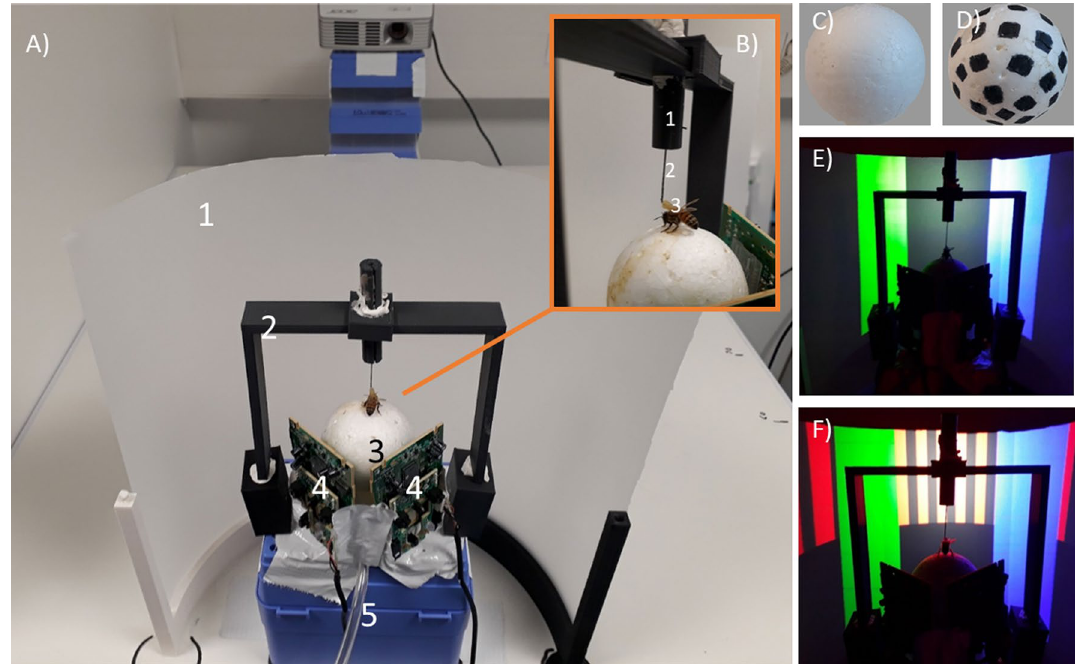
Figure 1. Experimental setup for 3D virtual-reality (VR) studies in honey bees. ( A ) Global view of the VR system. 1: Semicircular projection screen made of tracing paper. 2: Holding frame to place the tethered bee on the treadmill. 3: The treadmill was a Styrofoam ball positioned within a cylindrical support (not visible) and floating on an air cushion. 4: Infrared mouse optic sensors allowing to record the displacement of the ball and to reconstruct the bee’s trajectory. 5: Air arrival. ( B ) The tethering system. 1: Plastic cylinder held by the holding frame; the cylinder contained a glass cannula into which a steel needle was inserted. 2: The needle was attached to the thorax of the bee. 3: Its curved end was fixed to the thorax by means of melted bee wax. ( C , D ) Two types of Styrofoam balls used for assessing the importance of the ventral optic flow. ( C ) No ventral optic flow provided. ( D ) Ventral optic flow provided. ( E ) Color discrimination learning in the VR setup. The bee had to learn to discriminate a rewarded from a non-rewarded color cuboid. Cuboids were green and blue. In this case color training and testing was set in the ‘ Transparent Condition ’, i.e. no background was provided and the VR display contained only the two colored cuboids on an empty dark background. ( F ) Same as in ( E ) but in this case, the vertical background of the VR arena was covered by a vertical grating made of black and reddish bars. Depending on its movements, the background gave origin to three different conditions : the ‘ Vertical Grating— Optic Flow Condition ’, in which the grating was set in closed loop conditions with respect to the bee movements; the ‘ Vertical Grating—No Optic Flow Condition ’, in which the grating was moved in synchrony with the bee’s gaze so that no motion cues could be derived from the background; and the ‘ Rotating Vertical Grating Condition ’, in which the grating was displaced in the anti-clockwise direction across the screen at a constant speed, thus generating a constant optic flow that was independent of the bee’s